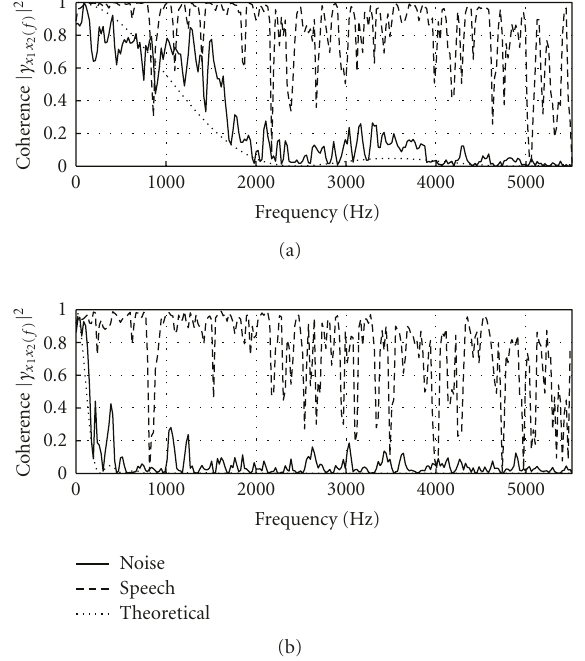
Figure 2: Coherence for noise and speech signals for tow di ff erent microphone